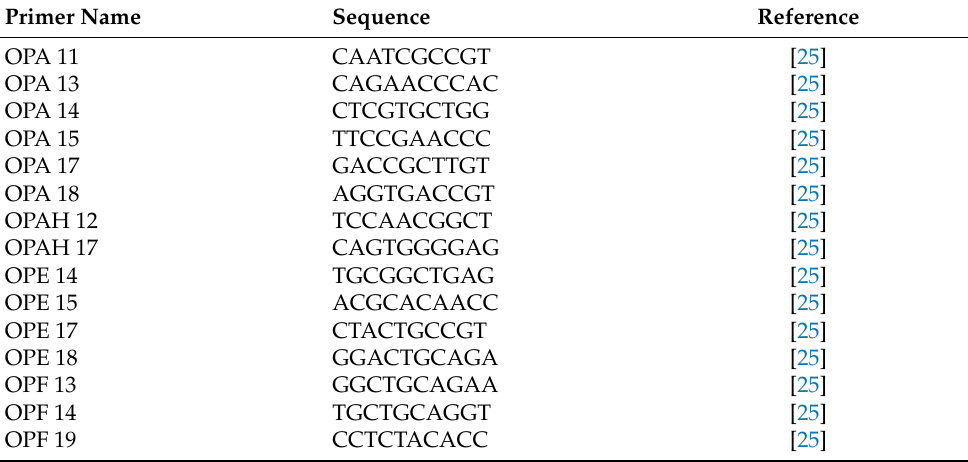
Table 1. Random amplified polymorphic DNA primer sequence used in genetic variation experiment of Gymnema inodorum